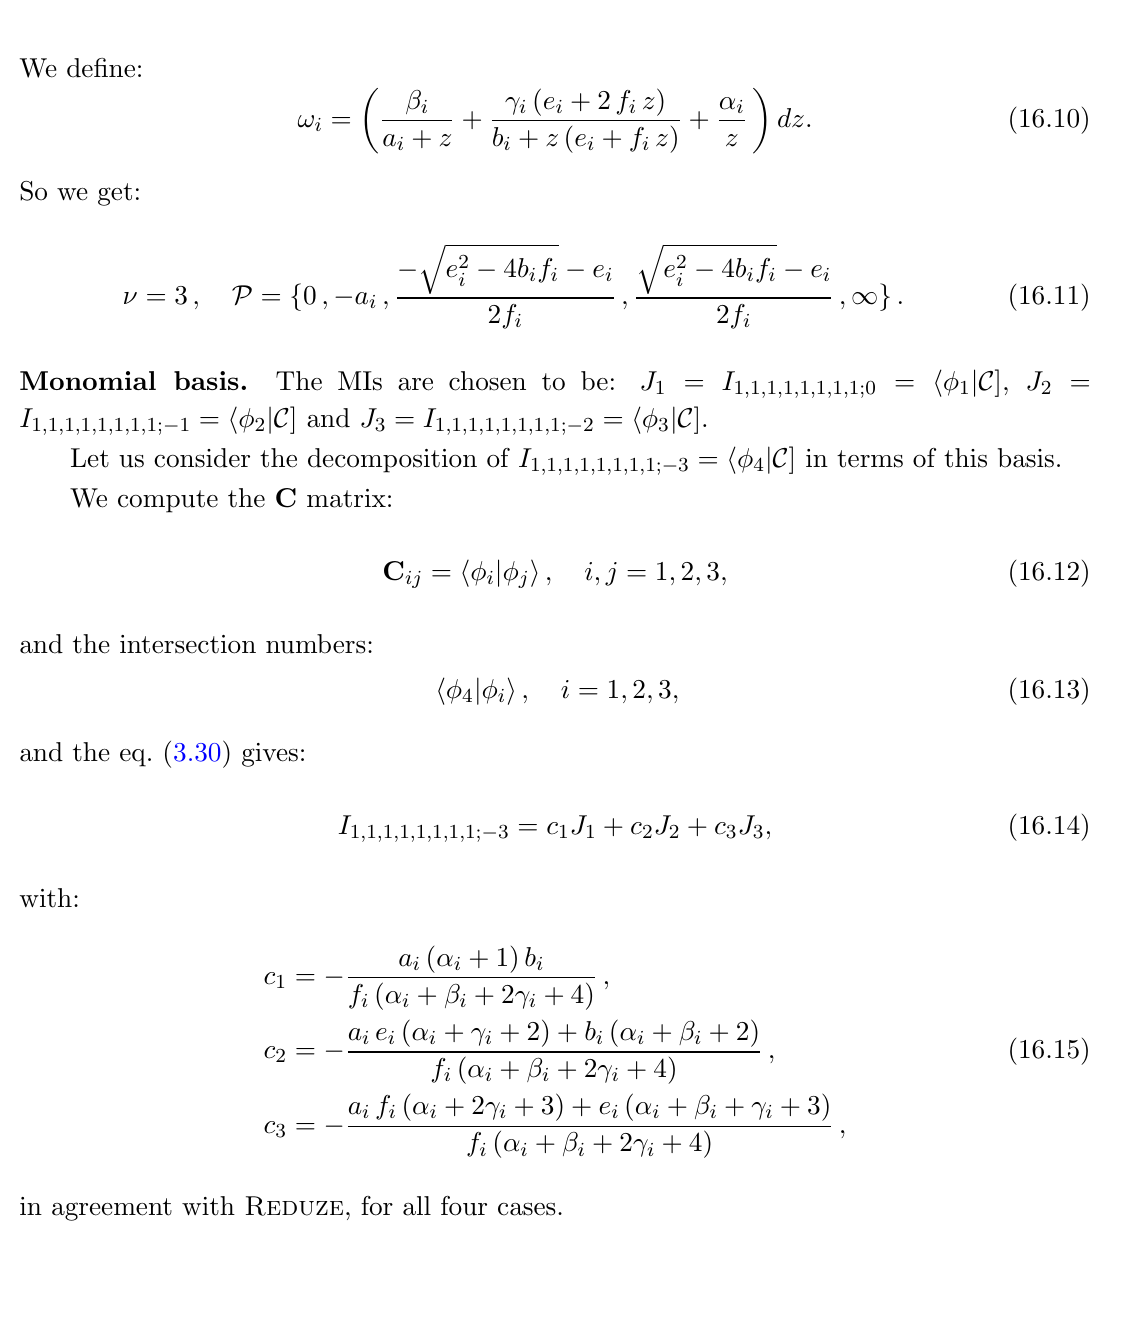
Figure 20. Multileg generalization of the topologies portrayed in (cid:12)gure